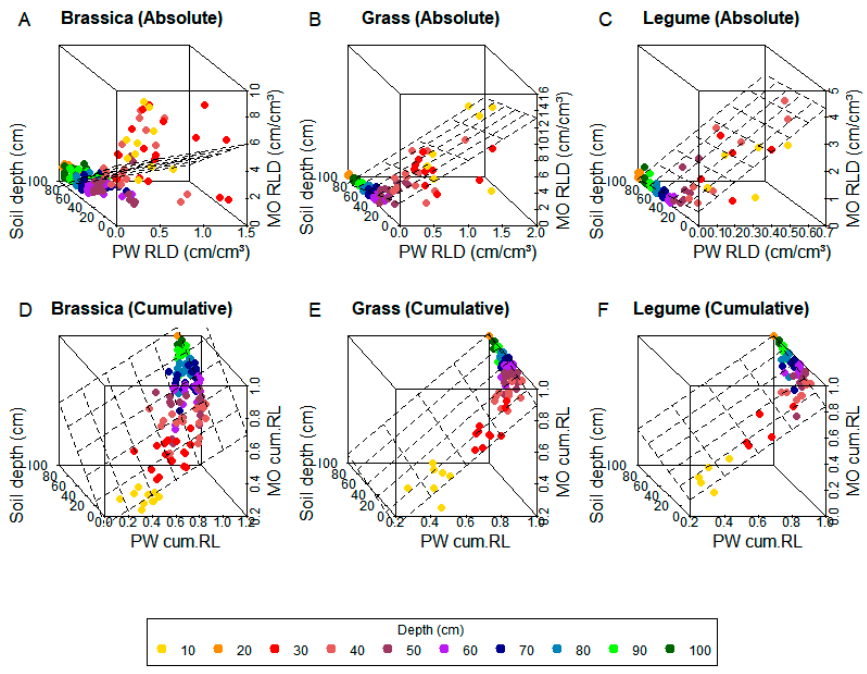
Figure 1. Linear regression fitting between monolith and profile wall root ‐ length density (RLD) in training data for absolute ( A – C ) and cumulative (cum.RL) data ( D – F ). Colors show soil depth (cm) of each value.